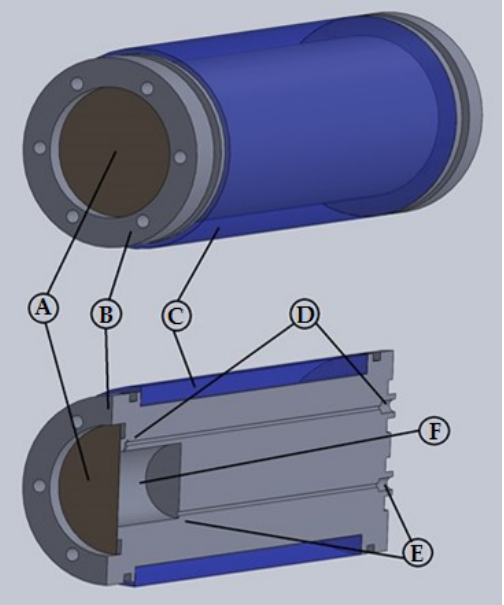
Figure 4. Prototype target for Eclipse target changer including (A) Havar or aluminum window foil, (B) an aluminum target body, (C) cooling water, (D) a front sweep gas flow path, (E) a rear sweep gas flow path, and (F) a target chamber for BNNT.